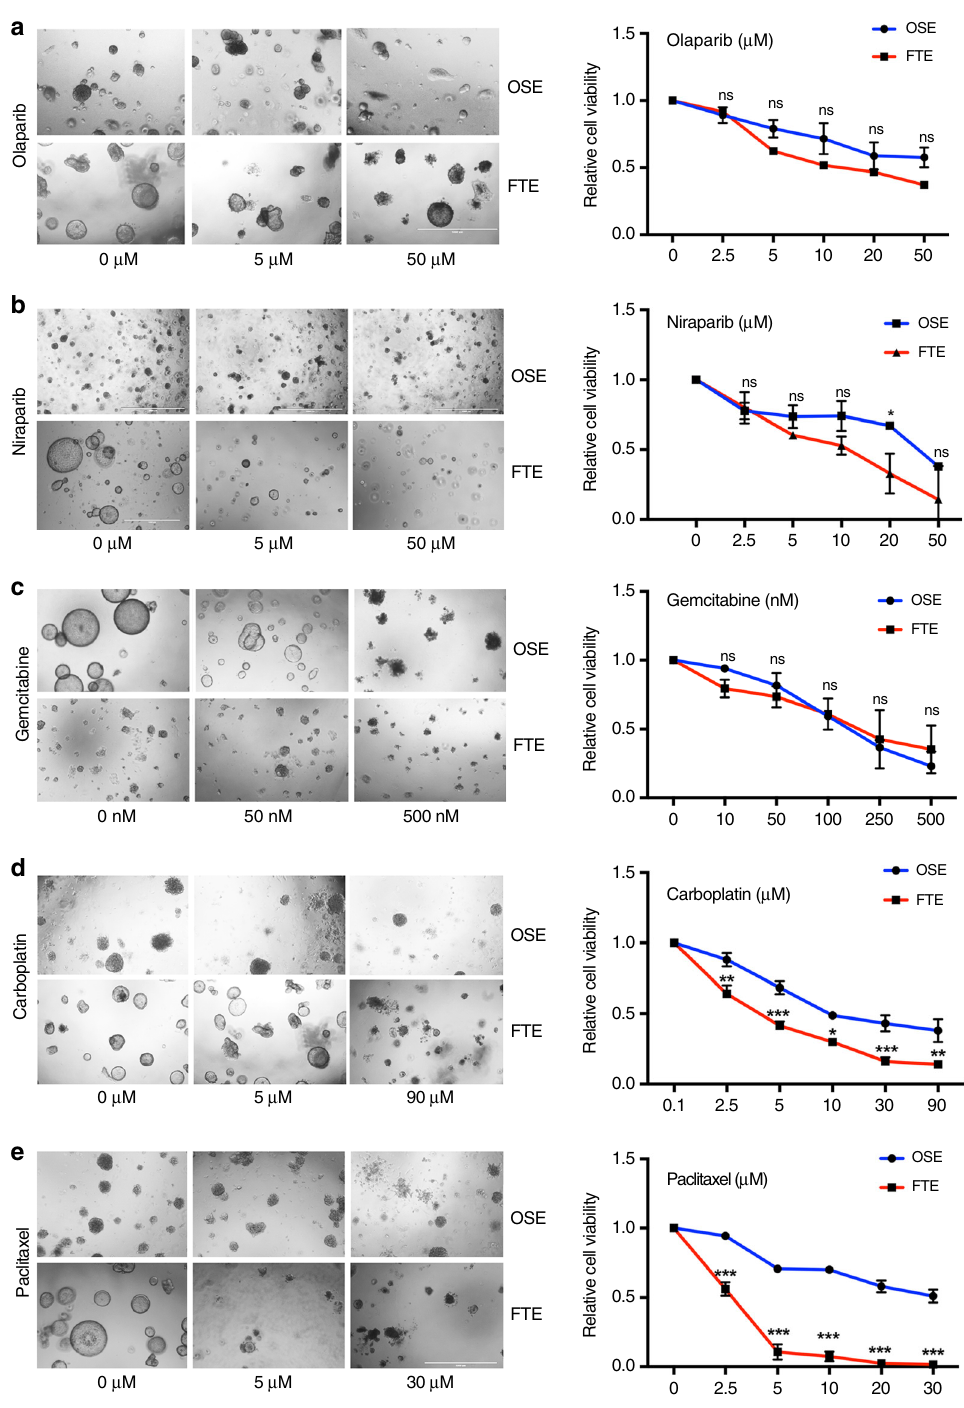
Fig. 8 Differential response of FTE-derived and OSE-derived tumor organoids to chemotherapy. Representative micrographs and dose-response curves for LPT (OSE) and PTPT (FTE) organoids, treated with: a Olaparib (0 – 50 μ M), b Niraparib (0 – 50 μ M), c Gemcitabine (0 – 500 nM), d Carboplatin (0 – 90 μ M), or e Paclitaxel (0 – 30 μ M). Cell viability was calculated relative to 0.01% DMSO-treated control cells, measured after 5 days of treatment. Each time point represents mean ± SEM of three independent biological replicates, each in triplicate (Source data are provided as a Source Data fi le). * P < 0.05, *** P < 0.001, Sidak ’ s multiple comparison